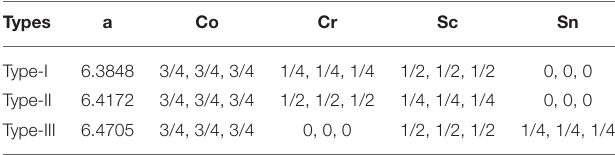
TABLE 1 | Equilibrium lattice equilibrium constants (Å) and atomic positions for three different types of crystals.